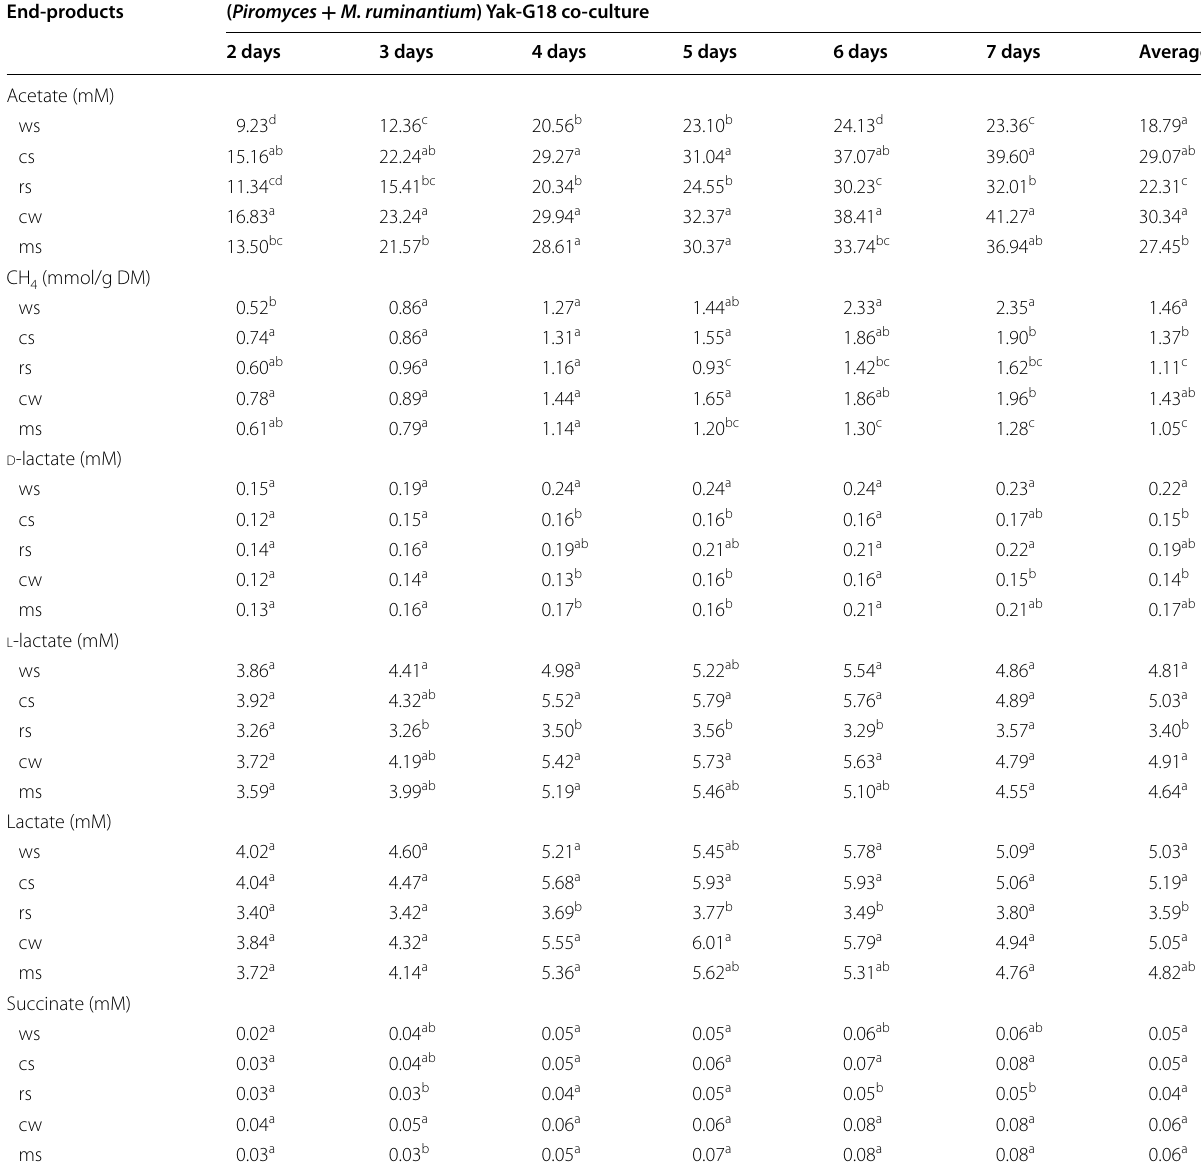
M. ruminantium ) Yak-G18 co-culture grown on chopped +